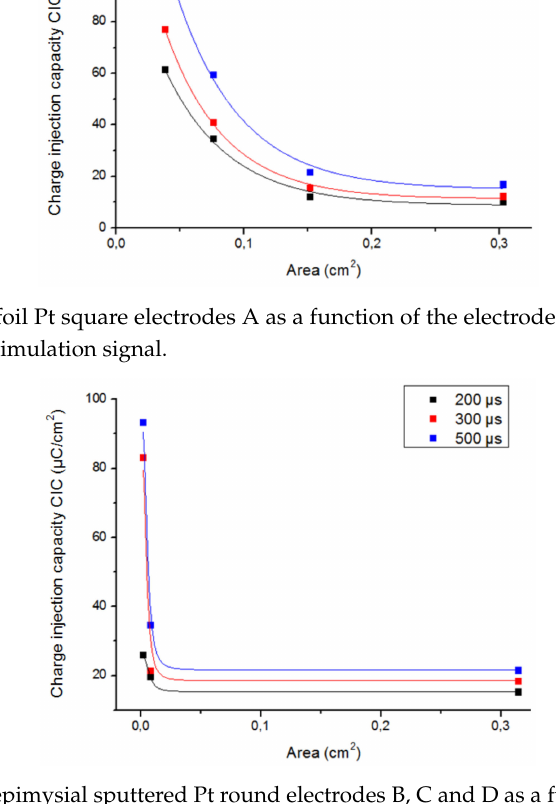
Figure 8. CIC of the epimysial sputtered Pt round electrodes B, C and D as a function of the electrode area for three di ff erent pulse widths of the stimulation signal.